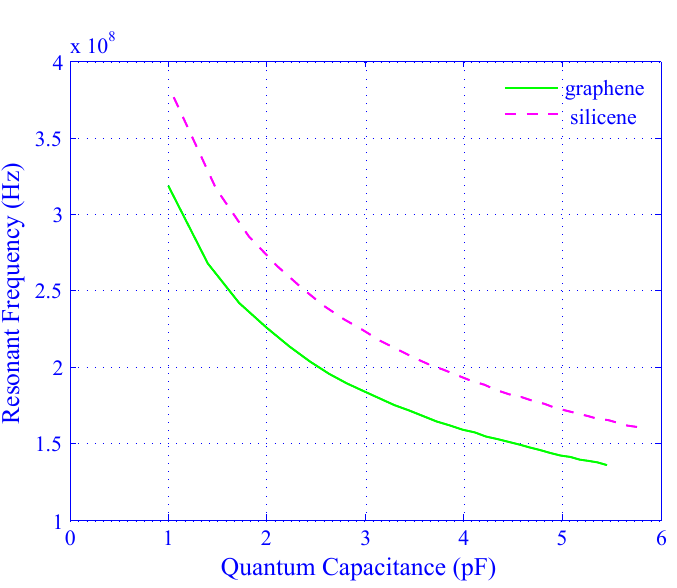
Figure 9. Effect of the quantum capacitance ( × 10 − 12 F) on resonant frequency for both the silicene (dotted line) and graphene (solid line).